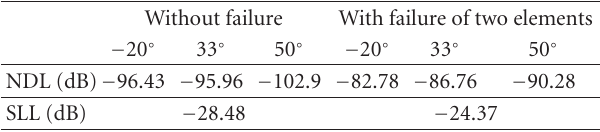
Table 6: Comparison of NDL and SLL for the configurations dis- cussed in Case 3.